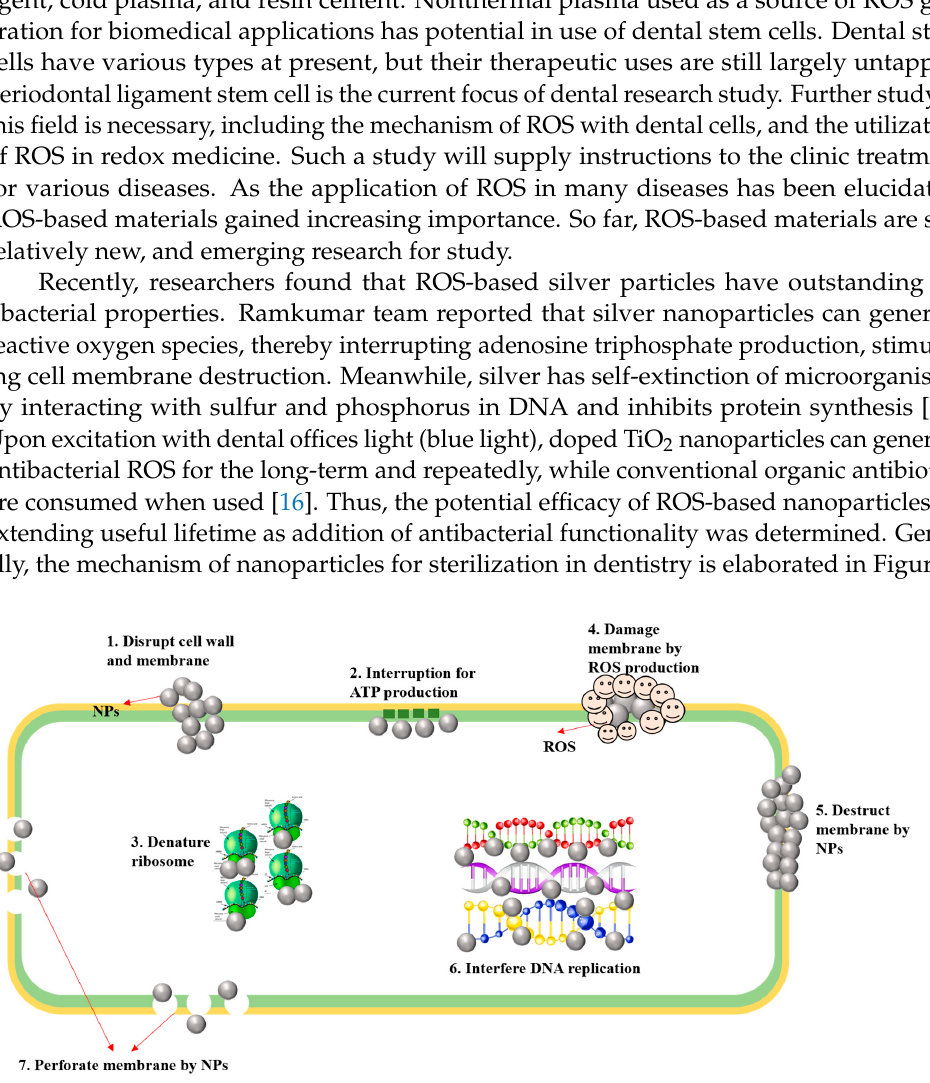
Figure 1. The mechanism of nanoparticles for sterilization in